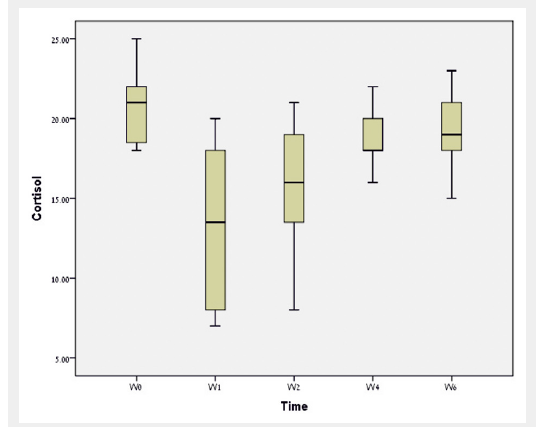
Poststimulation serum cortisol levels at baseline and at different time points in all the patients. Box plot showing distribution of serum cortisol levels at each time point, where the lower and upper borders of the box and the line inside it represent quartile 1 (Q1), Q3 and the median values, and the upper and lower whiskers represent Q3+ 1.5 interquartile range (IQR) and Q1-1.5 IQR, respectively. W0 = baseline; W1 = week 1; W2 = week 2; W4 = week 4;